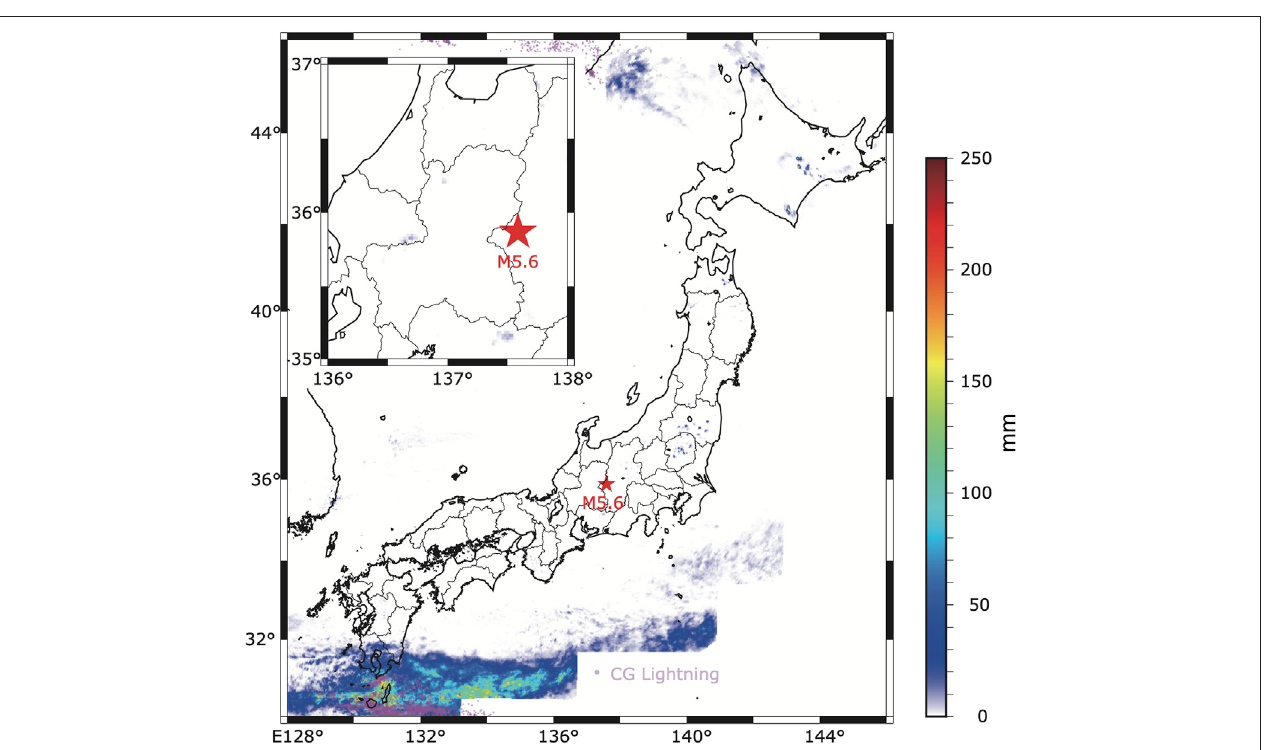
FIGURE4| Compositeradarechoandlightningmapfrom03:00to21:00June23,2017(JST).Thistimeperiodincludestheoccurrencetimeofsevenpulses. The compositeradarechoprovidedbyJMAcorrespondstothetotalrainfallatthe2 kmaltitudeduringtheperiod.NotethattheradarechoawayfromtheinlandofJapanwas notprovided.TheCGlightningwasprovidedbytheWWLLN.AstardenotestheepicenteroftheearthquakeonJune25,2017.Themagni fi ed fi gureneartheepicenteris shown in the upper left panel. No lightning was detected around the